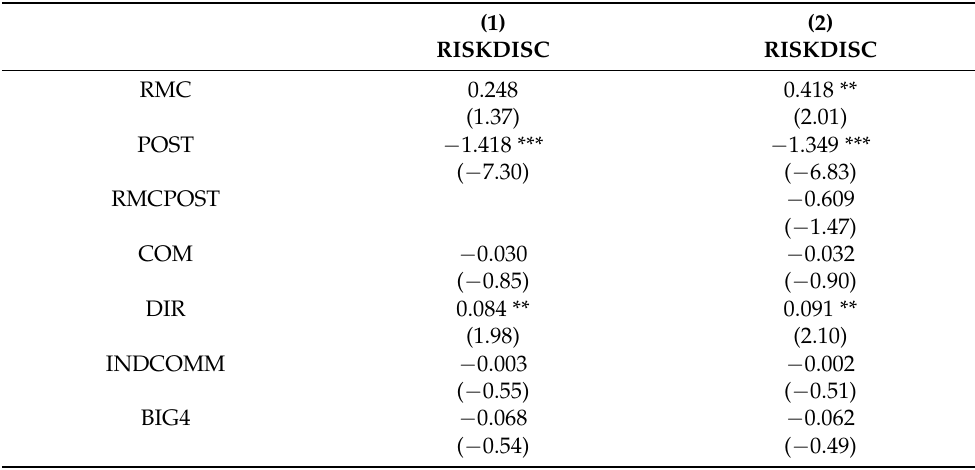
Table 9. Pre–post regulation for the financial and banking